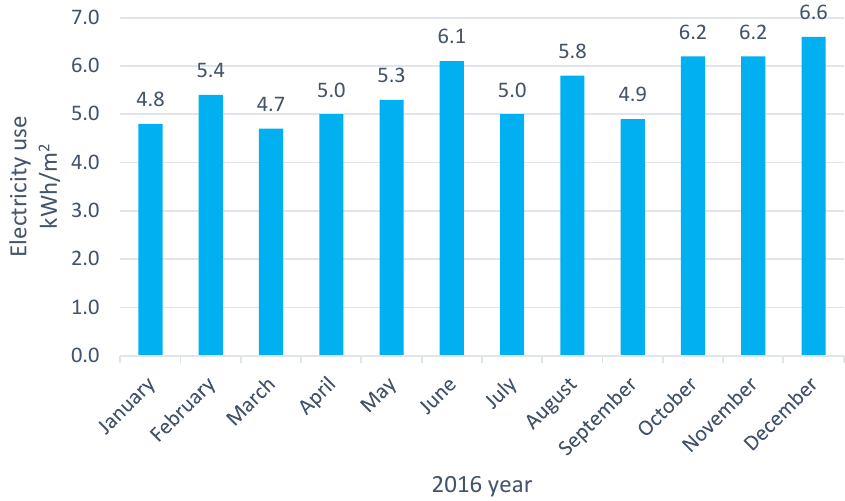
Figure 3. “D” building heat consumption for space heating (2016). Figure 3. “ D ” building heat consumption for space heating (2016).